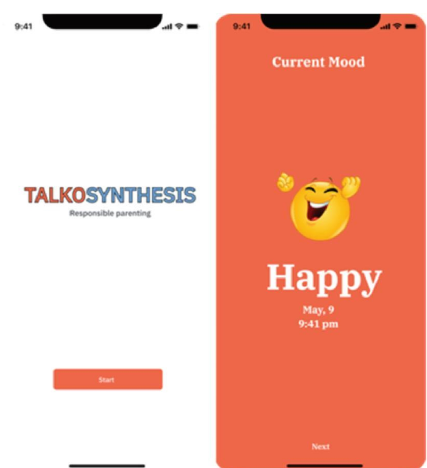
Figure 5: Current visualization of the main screen and the current mood.